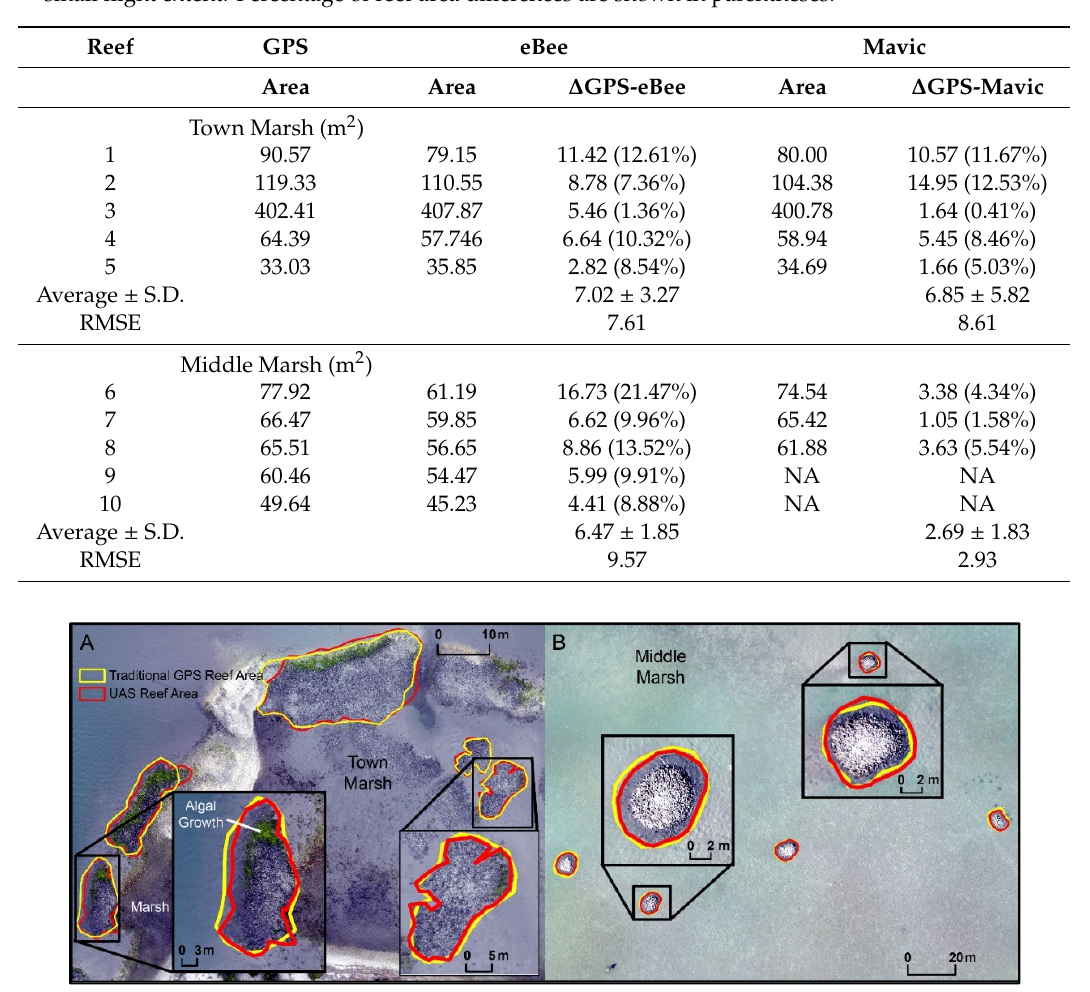
Table 2. GPS and UAS-derived intertidal average oyster reef elevation measurements in meters (NAVD88) from five reefs located in Town Marsh and Middle Marsh from a corrected eBee and uncorrected with GCPs and a Mavic Pro corrected with GCPs. Only three intertidal reef area measurements are included in the Mavic flights at Middle Marsh due to a small flight extent.